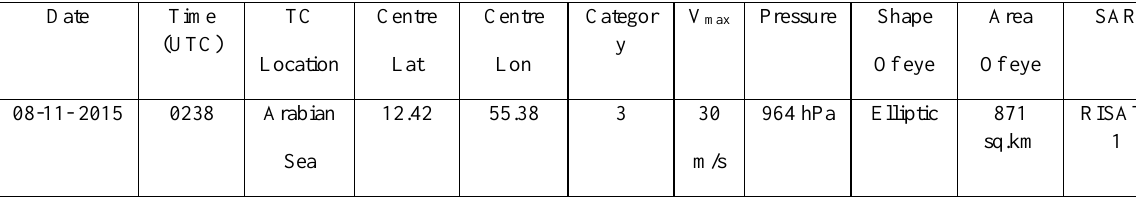
Table 1. Basic Megh cyclone information derived from RISAT-1 SAR.